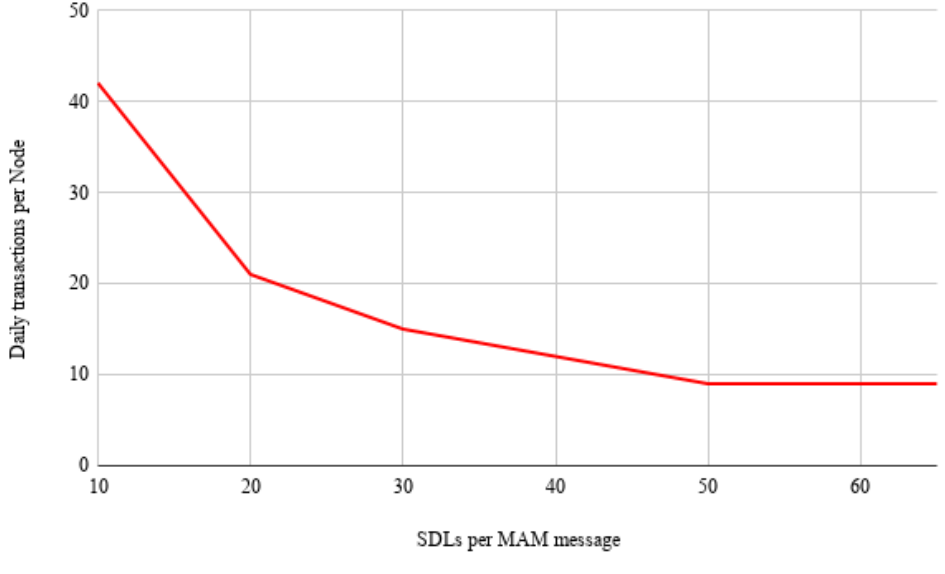
Figure 14. Number of Transactions vs sensor data logs (SDLs) / MAM message.